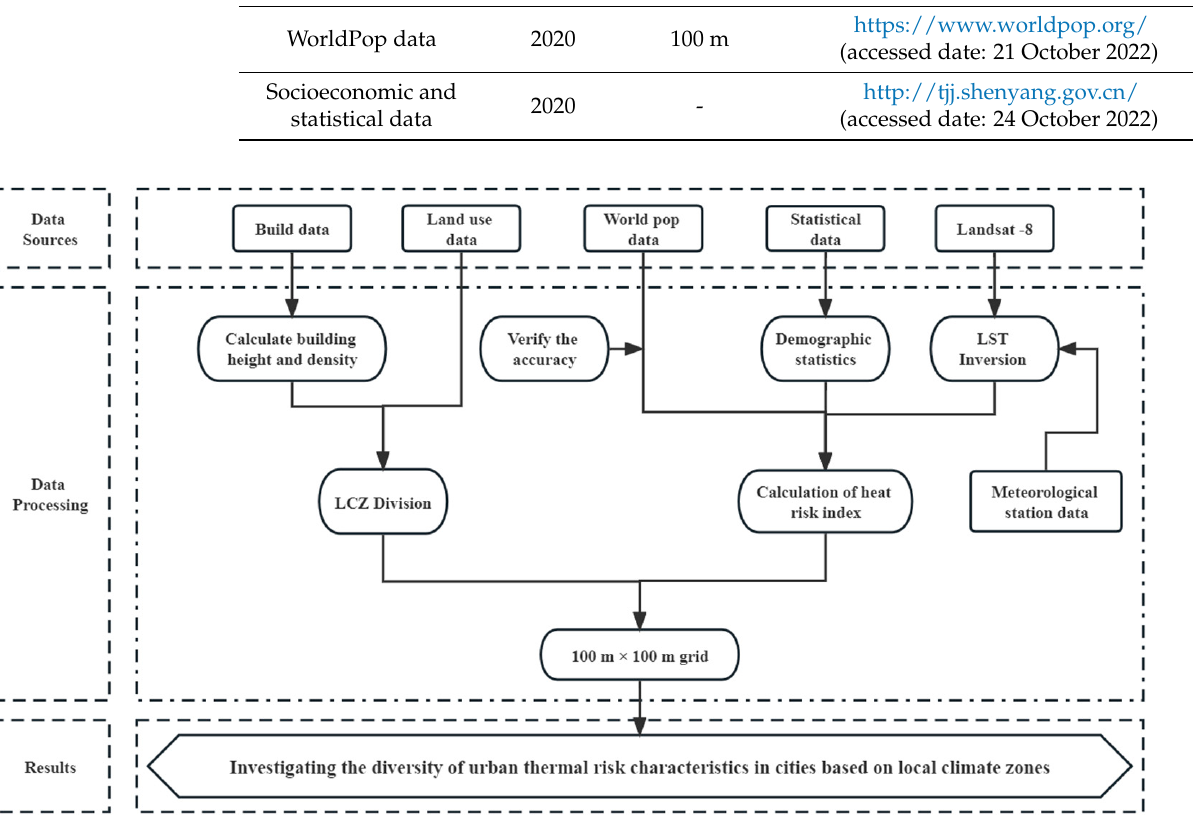
Figure 2. Research Figure 2. Research flowchart.